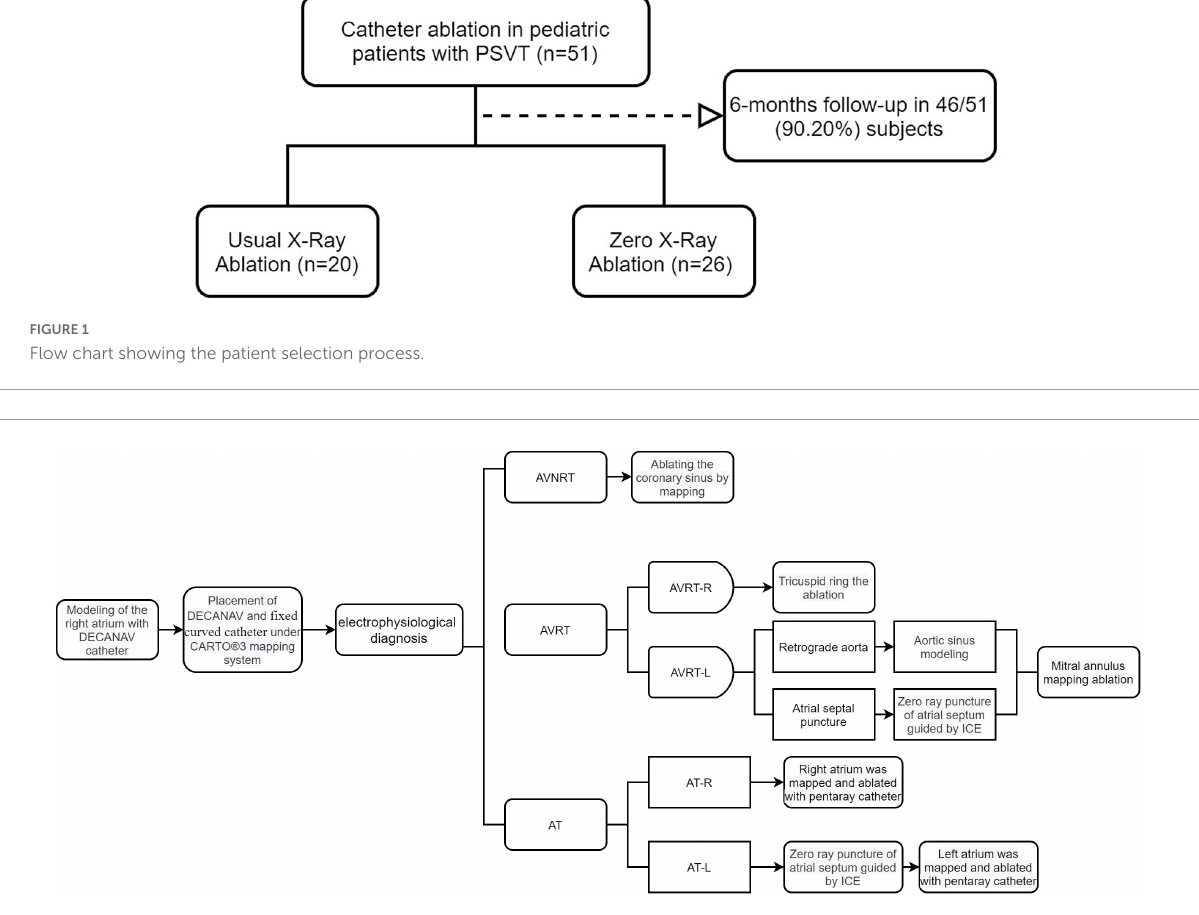
FIGURE2 Diagram showing how zero-fluoroscopy RFCA was performed according to type of supraventricular tachycardia. AT, atrial tachycardia; AT-L, left-sided AT; AT-R, right-sided AT; AVNRT, atrioventricular nodal reentrant tachycardia; AVRT, atrioventricular reentrant tachycardia; AVRT-L, left-sided AVRT; AVRT-R, right-sided AVRT; ICE, intracardiac